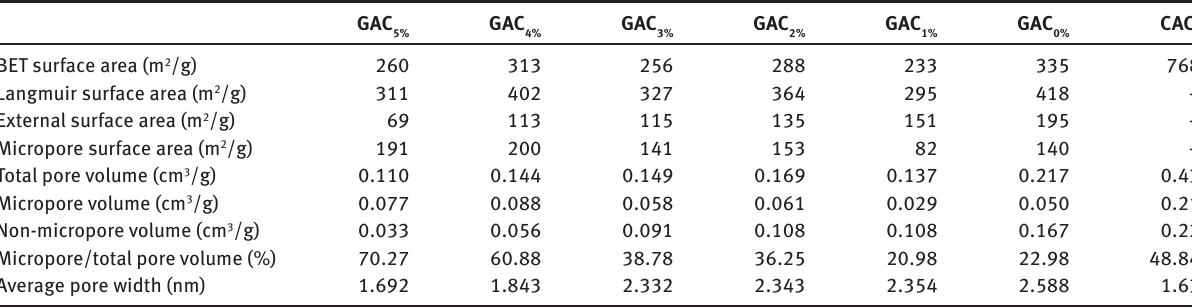
Table 1: Textural parameters of the glucose activated carbon (ACs) and commercial